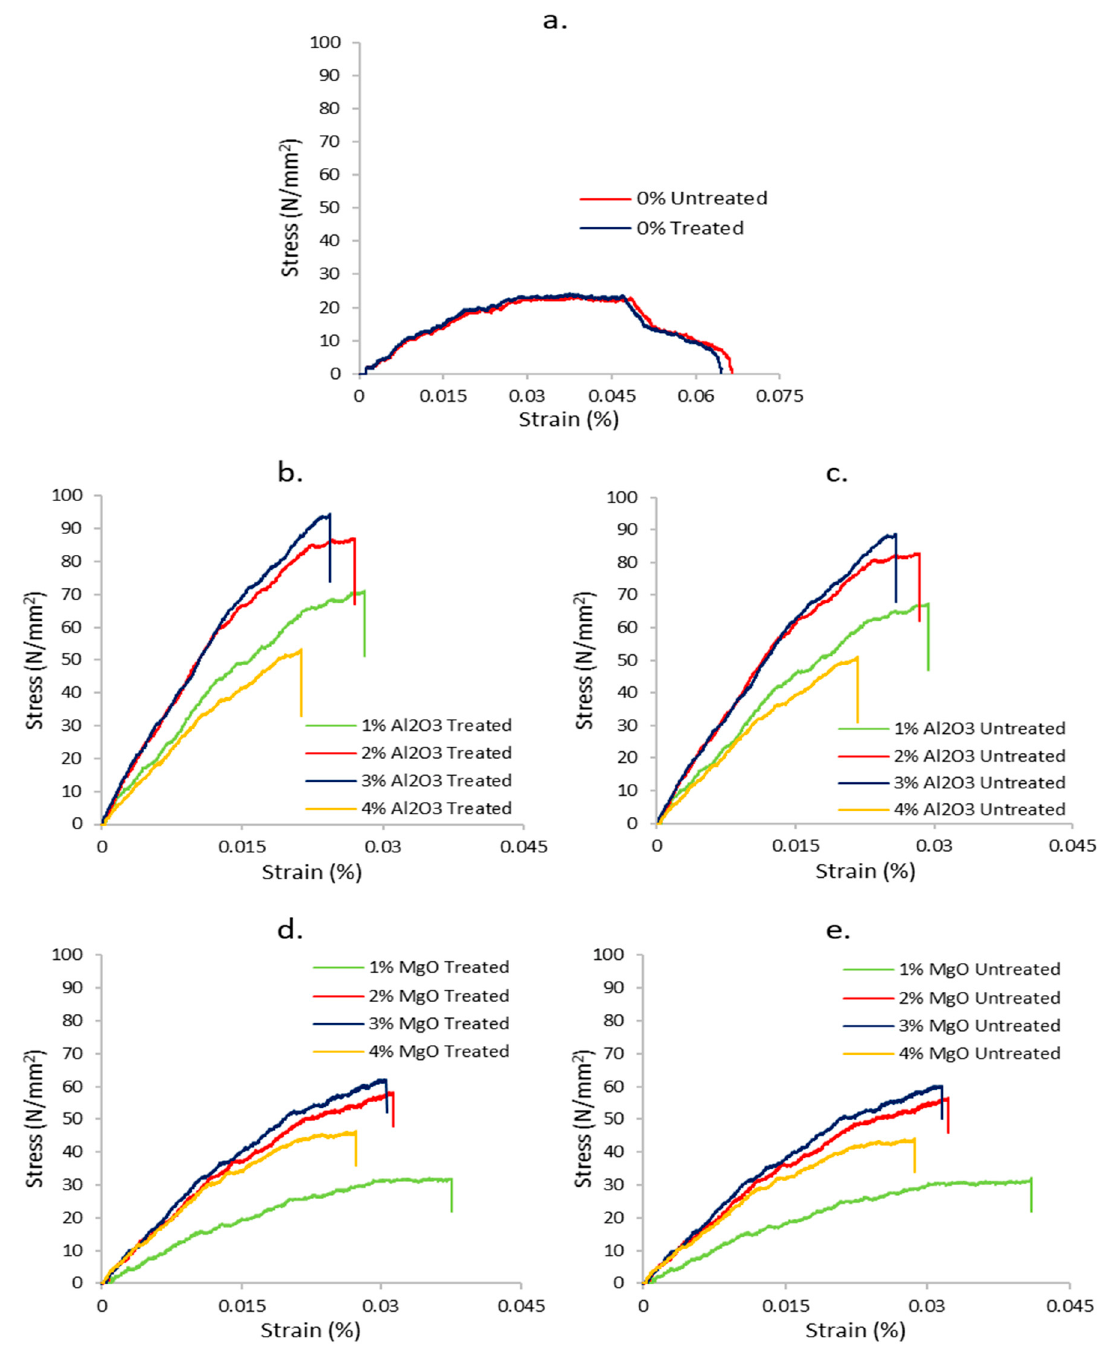
Figure 4. Flexural stress–strain curves of ( a ) neat composite, ( b ) Al 2 O 3 —treated, ( c ) Al 2 O 3 —untreated, ( d ) MgO—treated, and ( e ) MgO—untreated flax/PLA epoxy hybrid composites.